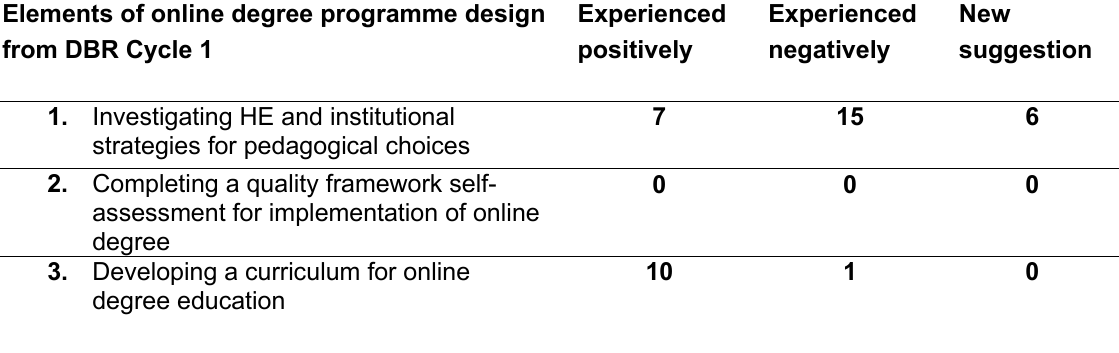
The frequency of the teachers’ experiences according to the elements of the initial ODP model Elements of online degree programme design from DBR Cycle 1 1. Investigating HE and